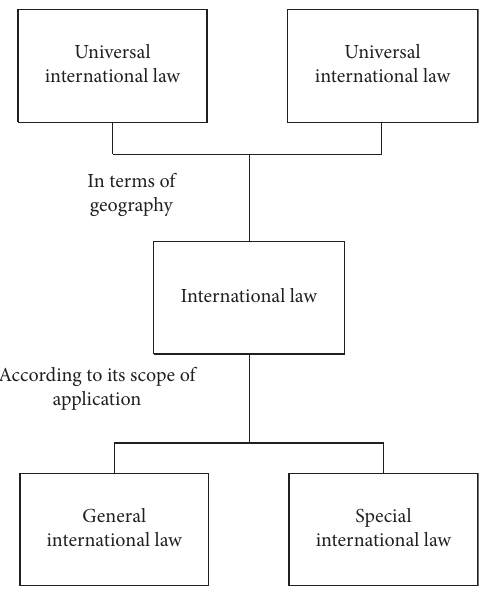
Figure 1: The division of international law.